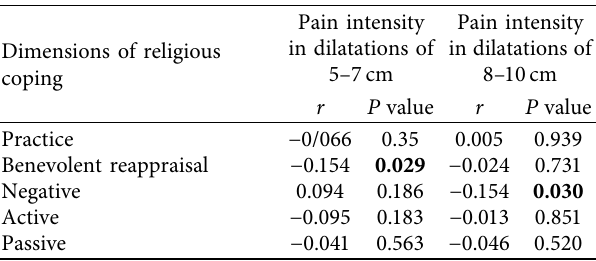
Table 2: The relationships between religious coping and pain severity of the primiparous women ( n �